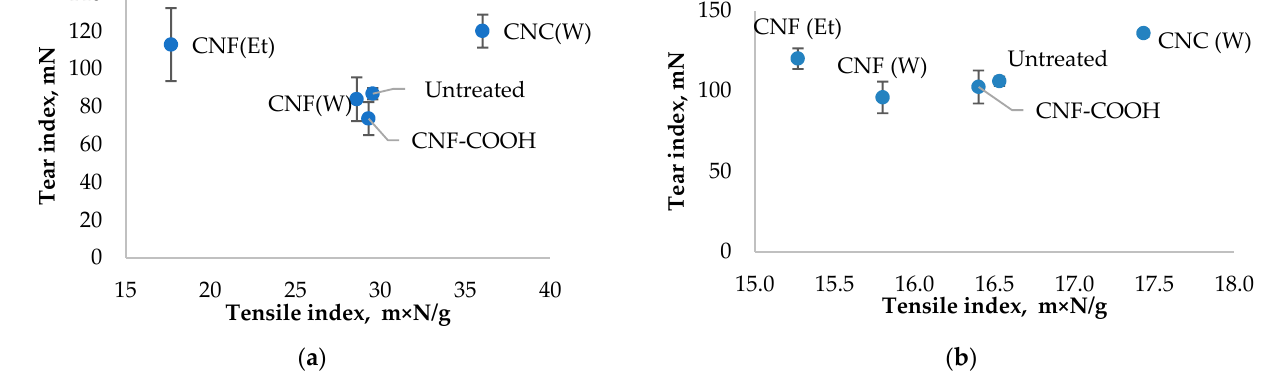
Figure 9. Tear and tensile indices for WBP reinforced with NC: ( a ) MD; ( b ) CD.